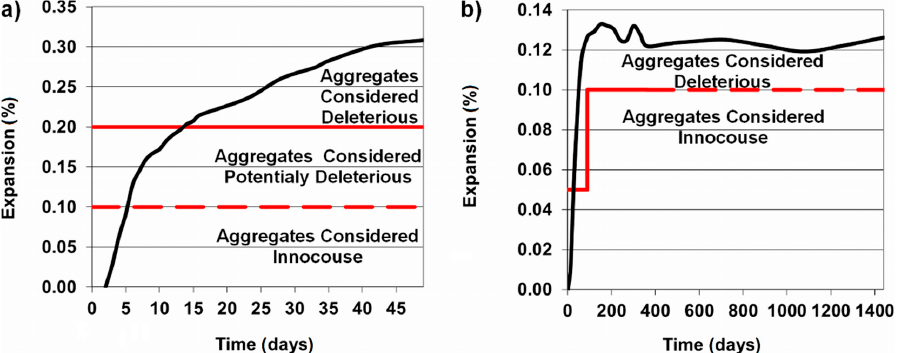
Figure 4. Expansion of mortar with gravel aggregate according to ( a ) ASTM C 1260, ( b ) ASTM C 227.